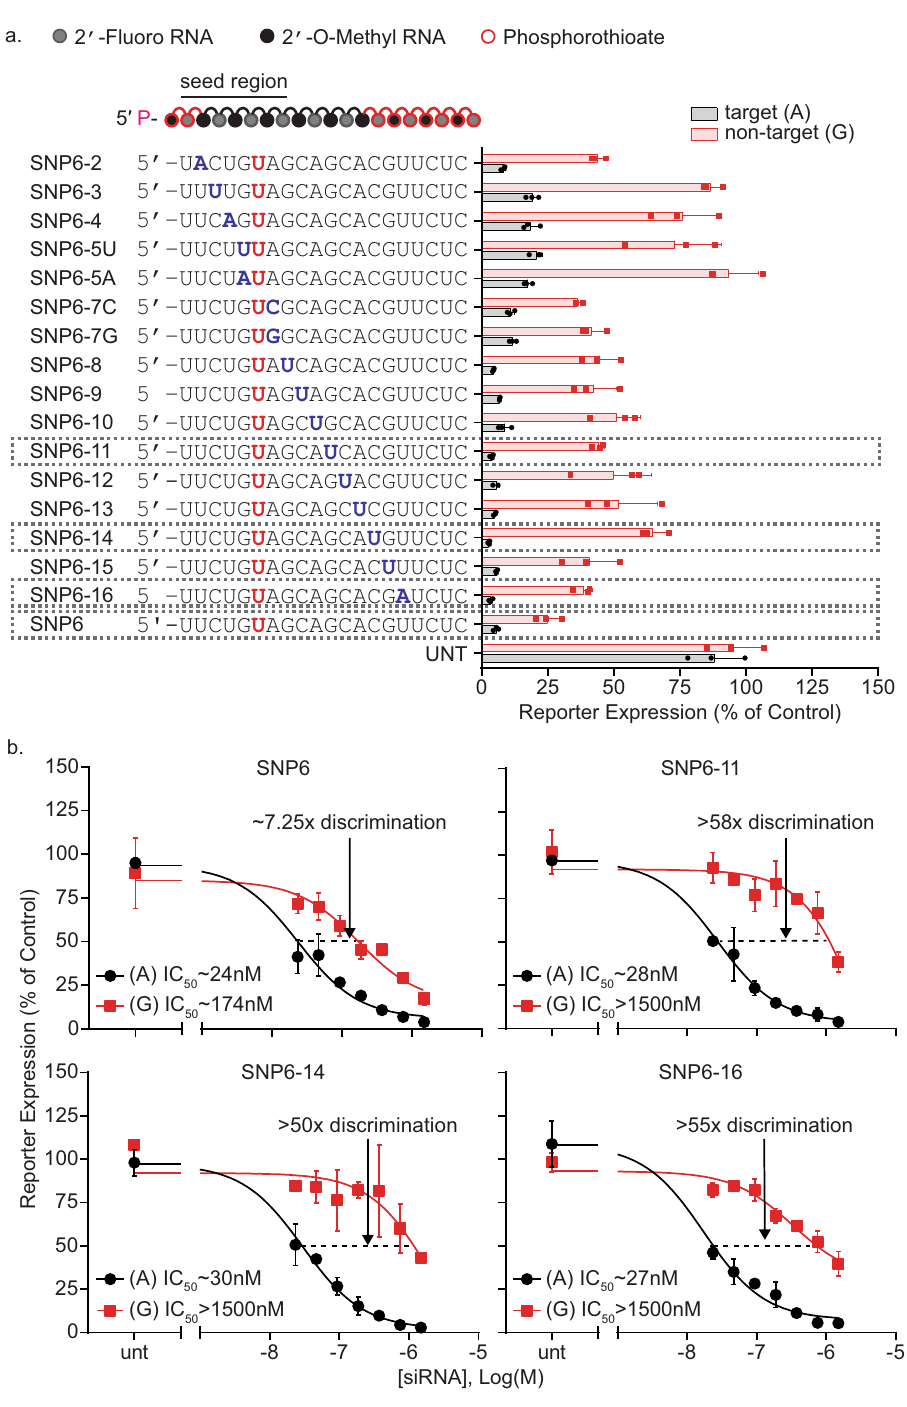
Fig. 2 | A systematic screen of siRNAs targeting a heterozygosity at site rs362273yieldsmultiplecompoundsinwhichasecondarymismatchimproves allelic discrimination. a In certain positions, adding an intentional mismatch to a SNP-targeting siRNA improves discrimination without impairing target silen- cing. Compounds were tested using a dual-luciferase reporter assay system in HeLa cells. The (psiCheck) reporter plasmids contain a 40mer region of hun- tingtin, including the target (A) SNP isoform, and non-target (G) SNP isoform. Cells were treated for 72h at 1.5 µ M of siRNA. An siRNA selected from the pri- mary screen (SNP6) (Fig. 1) was used as a template sequence and a secondary